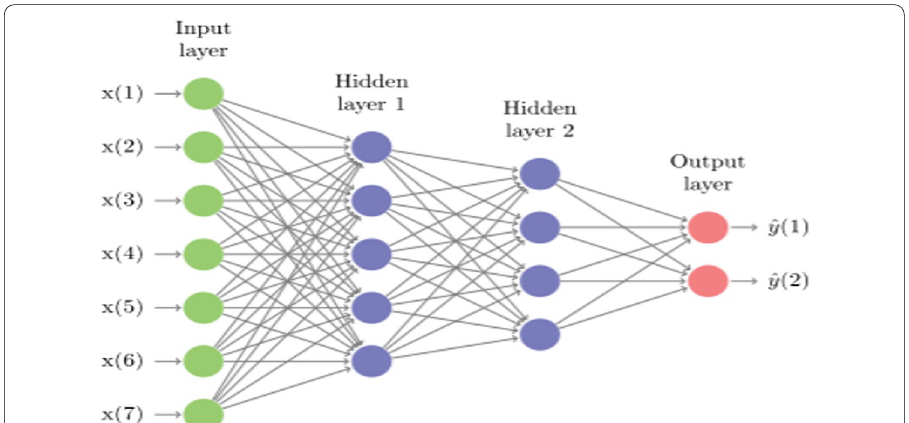
Fig. 1 The representation of a multi-layer neural network (Dixon et al. 2017). The input layer consists of explanatory variables called features, and the information is forwarded from this layer to the hidden layers. On the arcs of hidden layers, parameters called weights and biases exist. The goal of the network is to find the optimal parameter settings that minimize the error between the estimated and the actual target